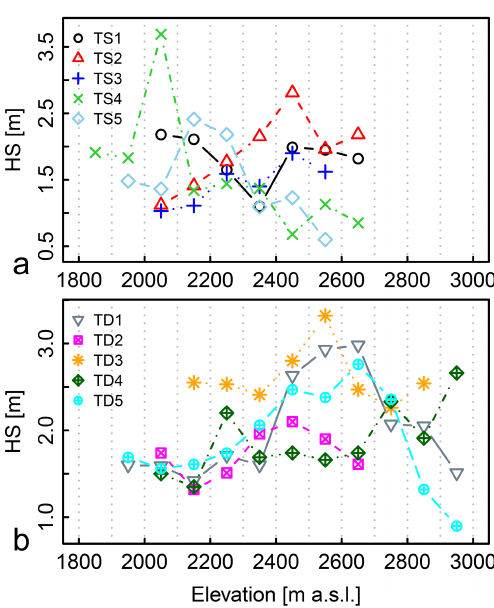
Figure 7. Elevation gradients of selected transects from the Strela mountain range (a) and the Dischma valley (b)